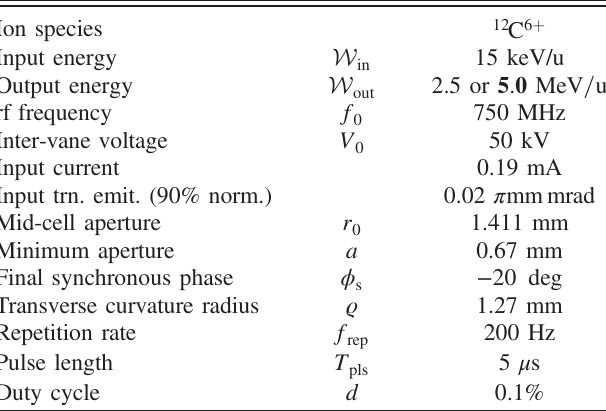
TABLE I. Carbon-RFQ general design parameters.